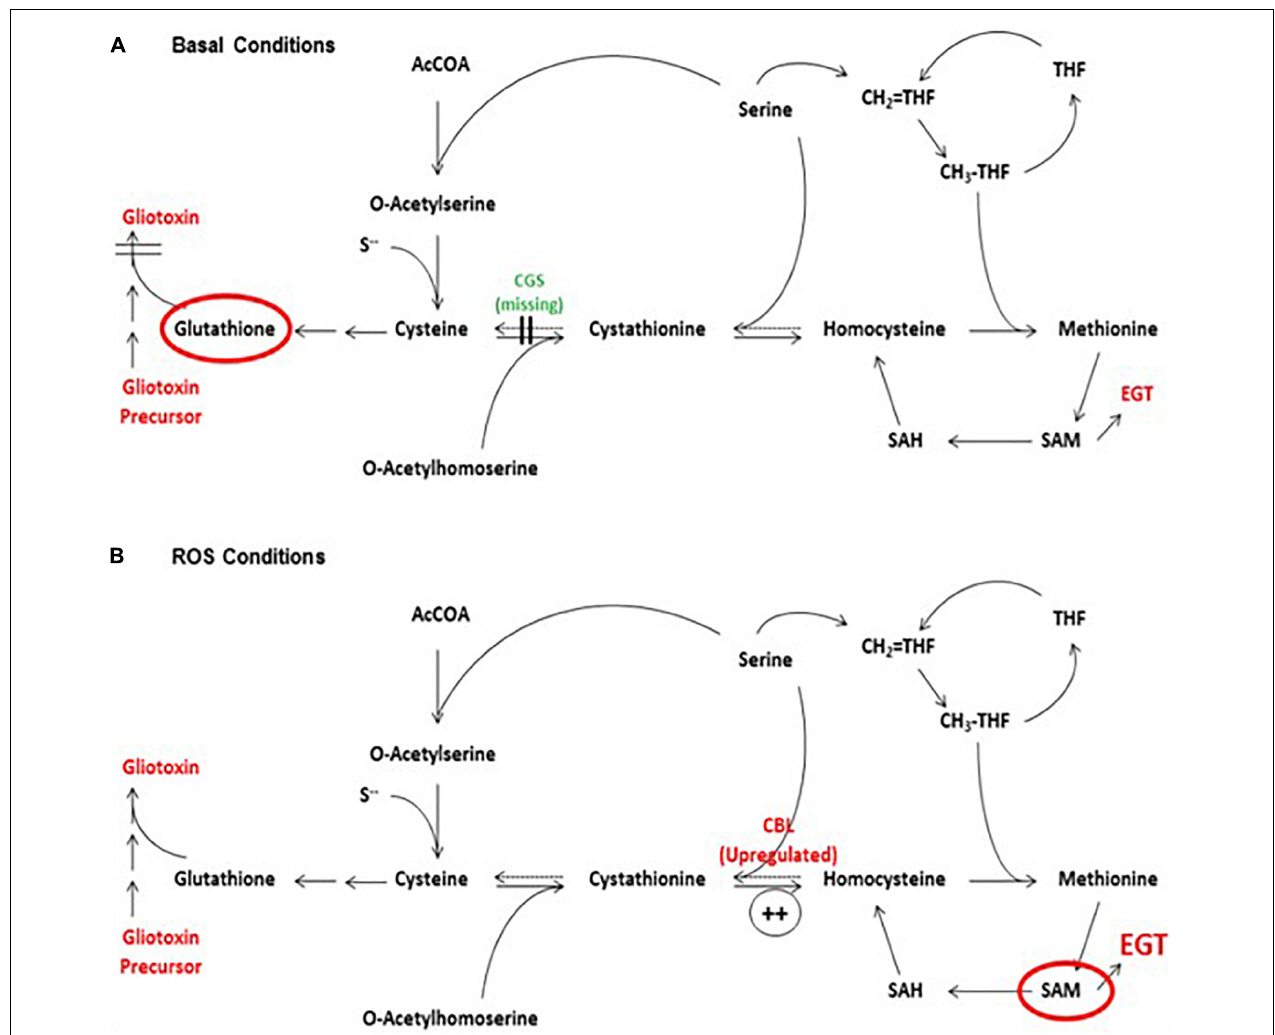
FIGURE 6 | The proposed “cystathionine switch” in A. fumigatus . (A) Comparison of (cid:49) egtA 26933 and A. fumigatus wild-type under basal conditions reveals the absence (undetectable) of cystathionine γ -synthase (CGS), which normally converts cysteine to cystathionine. This may facilitate a switch towards increased GSH production by virtue of Cys excess. (B) Comparison of (cid:49) egtA 26933 and ATCC26933 upon addition of 3 mM H 2 O 2 resulted in an increased abundance of cystathionine β -lyase (CBL), which converts cystathionine to homocysteine. This is predicted to result in increased production of SAM, which is essential for